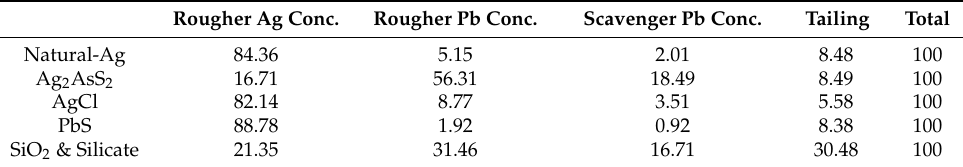
Table 4. The recovery rate of Ag (%). Rougher Ag Conc. Rougher Pb Conc. Scavenger Pb Conc. Total Natural-Ag